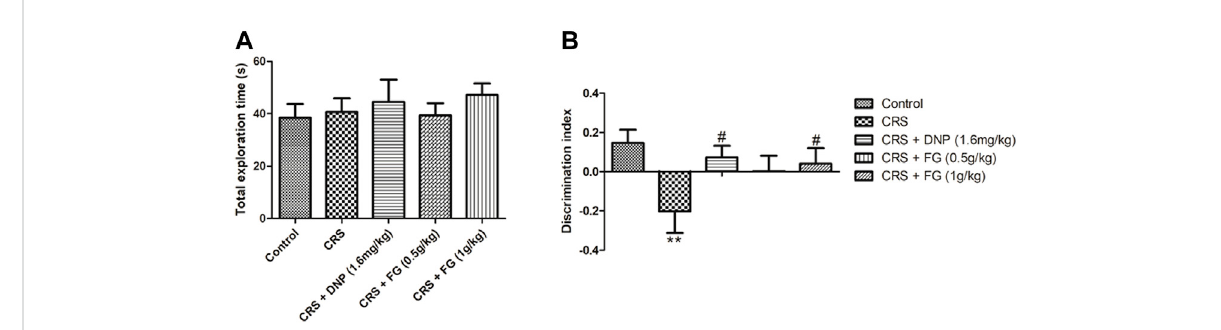
FIGURE 4 Effect ofCRS, FG, and DNP on the object location recognitiontest of mice induced by CRS. (A) Total exploration time in familiar phase. (B) DI in testphase.Valuesrepresentthemean±S.E.M. n =8~12mice/group.** p < 0.01comparedwiththecontrolgroup; # p < 0.05comparedwiththeCRS group.